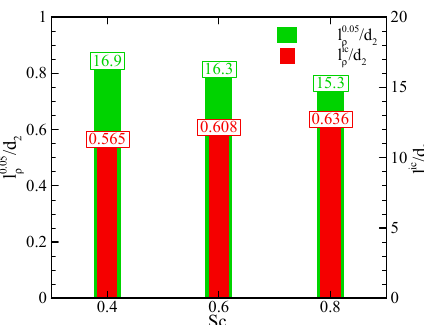
Figure 17. A bar chart of liquid length and jet length of oxygen with respect to different turbulent Schmidt numbers. Both lengths are non-dimensionalized by diameter of circular oxidizer pipe at exit ( d 2 ).